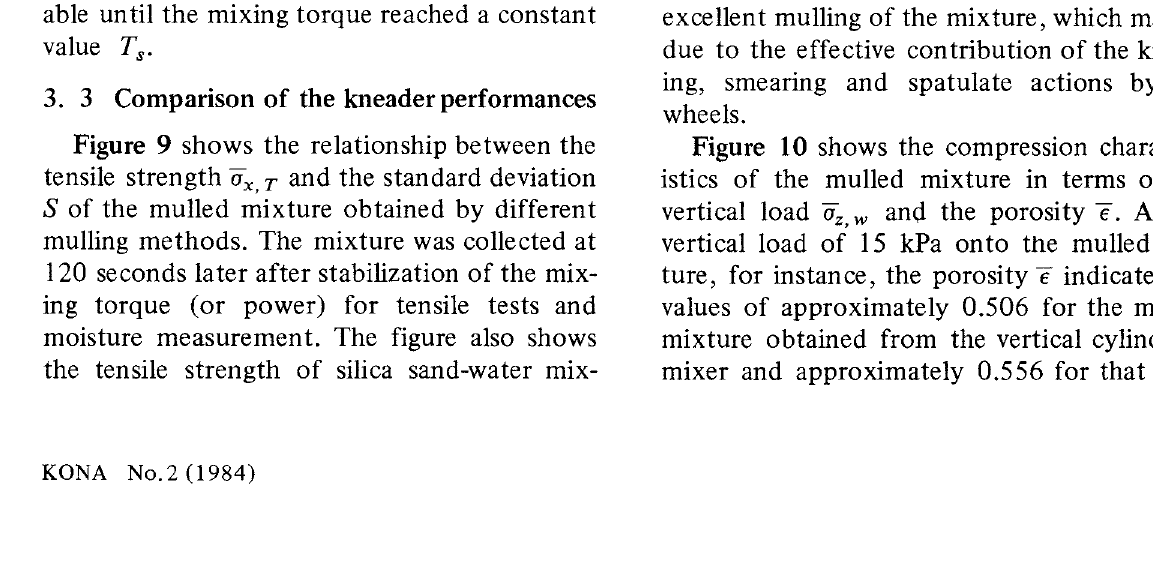
ture, dried bentonite and dried coal powder. As ax, T of green mold sands (open circle) obtained by manual mulling is five times as large as that (open square) of the silica-water mixture. This difference may reflect the binding effect of water-impregnated bentonite. The value